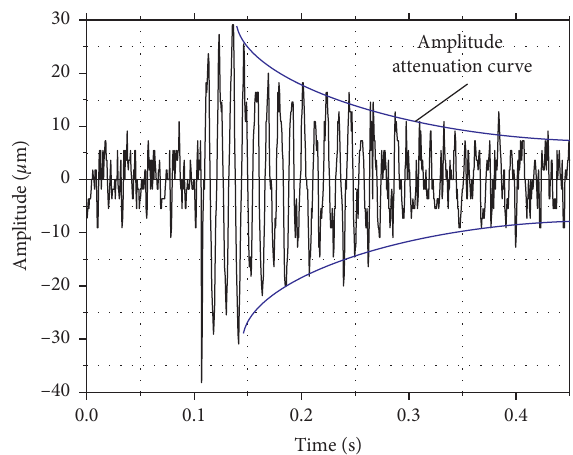
Figure 9: Free attenuation curve in the vertical direction of the spindle front end